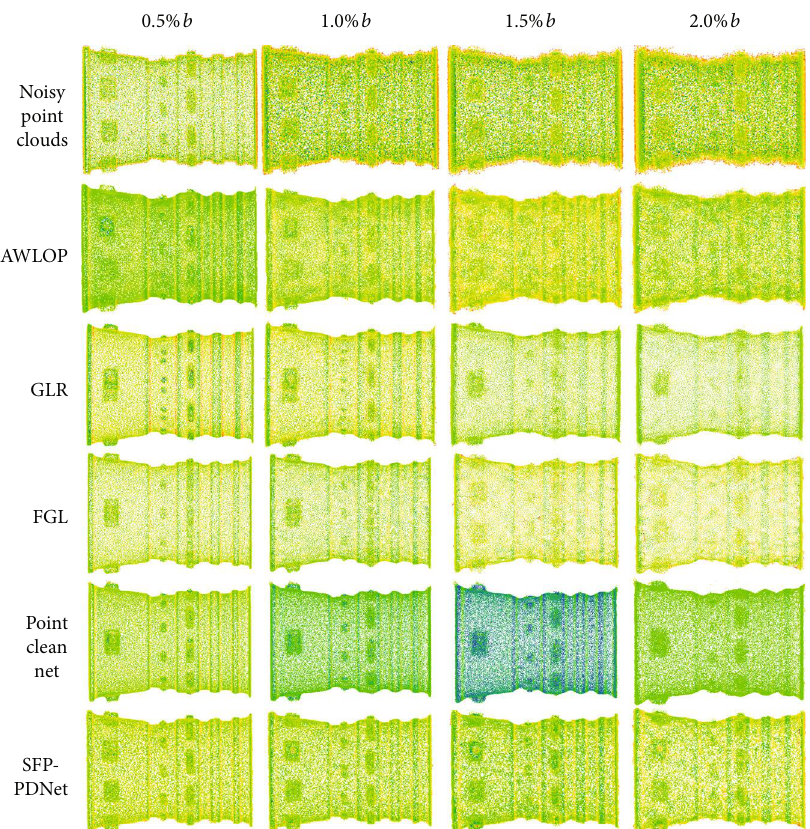
Figure 22: Qualitative comparison of di ff erent Table 2: Quantitative comparison of di ff erent methods (CD between denoised point clouds and clean point clouds). Noise scale